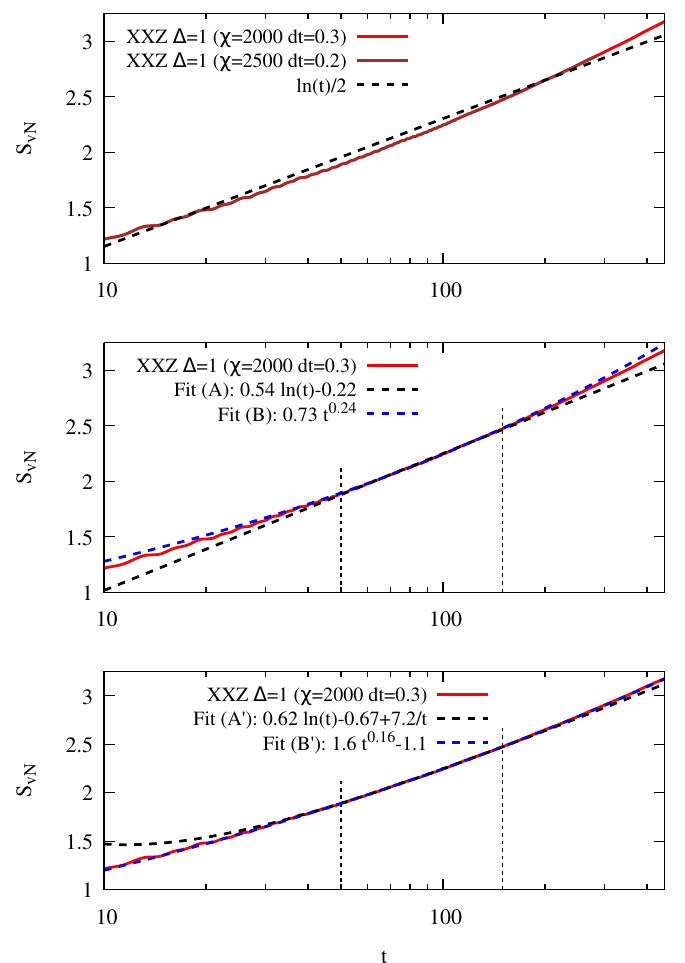
Figure 11: Von Neumann entanglement entropy for the quantum model at ∆ = 1, for a partition in the center of the chain. Top: tDMRG calculations with L = 800, time step dt = 0.2, maximum bond dimension χ = 2500, MPS truncation parameter 10 − 11 , with time up t = 286 (brown line). At the scale of the plot the results are unchanged when taking dt = 0.3, χ = 2000 and the truncation parameter to 10 − 10 (data shown up to t = 400, red line), which indicates a good convergence. We also show 1 ln ( t ) (see Sec. 7.2), which however underestimates the entropy growth 2 at large times. Middle: two-parameter fits of the entanglement entropy, with (A) a ln ( t )+ b or (B) a power law c t d . Bottom: three-parameter fits of the entanglement entropy, with (A’) a ln ( t )+ b + c / t or (B’) c t d + e . The fit (B’), with an exponent close to 1 / 6, seems to offer the best description of the data, but a logarithmic growth cannot be excluded. All the fits are performed in the interval [ 50,150 ] (dashed vertical